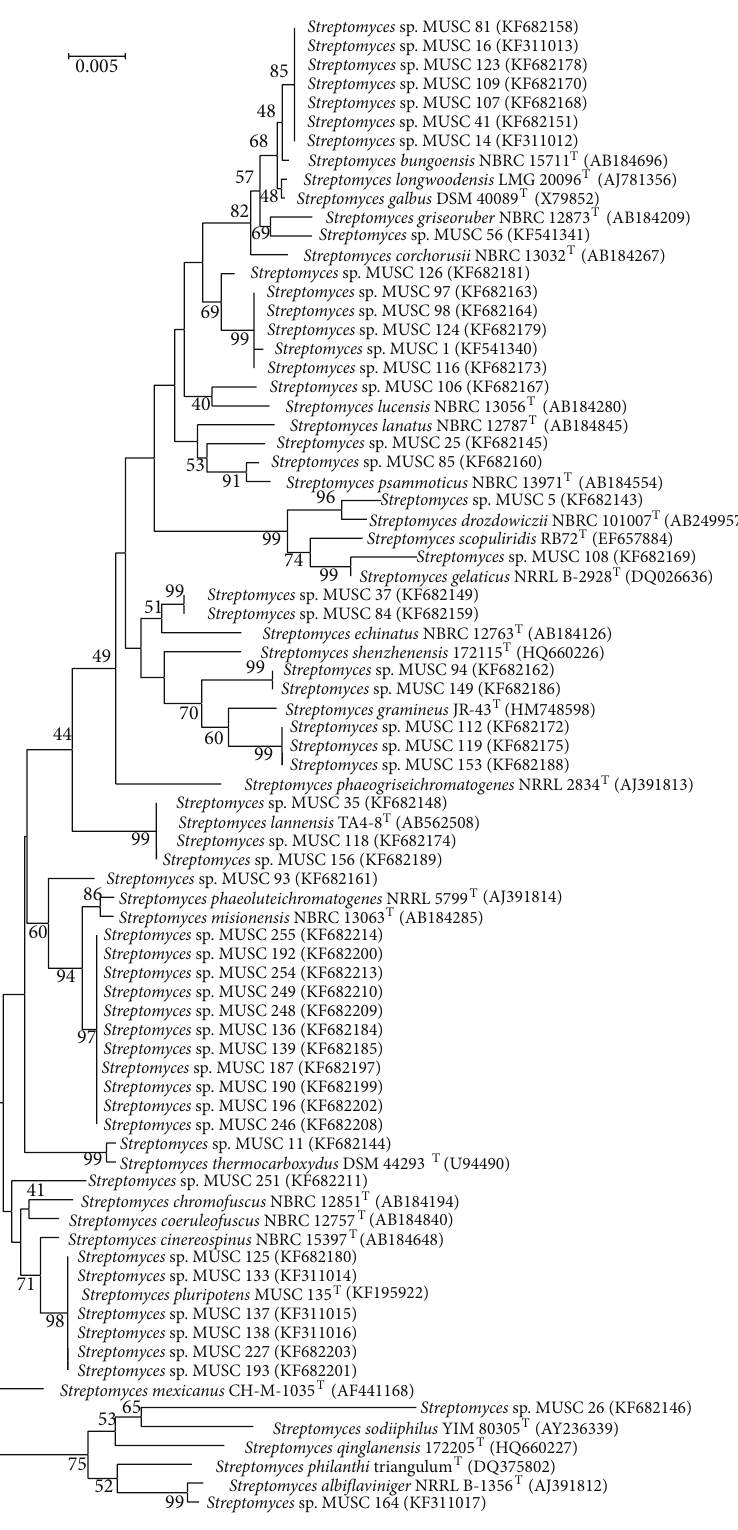
Figure 2: Phylogenetic tree based on 16S rRNA sequences using neighbour-joining method for 52 isolates of Streptomyces sp. and their closely related type strains. Bootstrap values ( > 40%) based on 1000 resampled datasets are shown at branch nodes. Bar, 5 substitutions per 1000 nucleotide